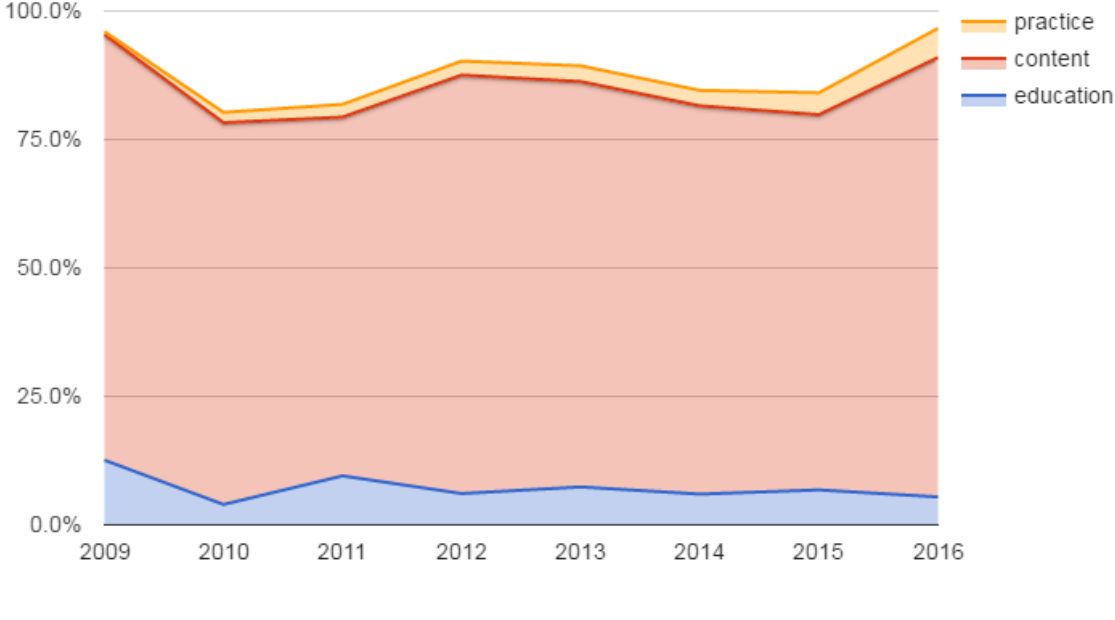
Figure 6. Tweet topical categories by